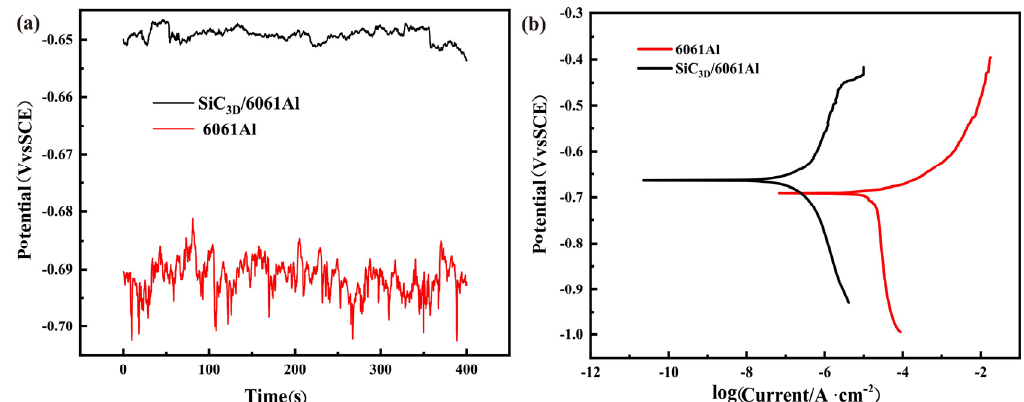
Figure 3. ( a ) Open circuit potential (OCP) curve; ( b ) potentio-dynamic polarization (PDP) curve. Table 2. Corrosion potential and corrosion current.